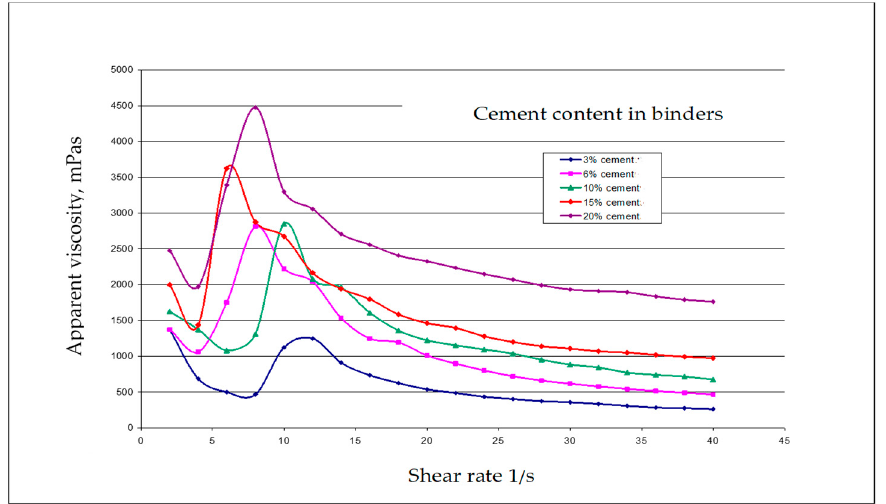
Figure 5. Values of the Bingham flow limit for suspensions prepared on the basis of kaolinite-type clay.